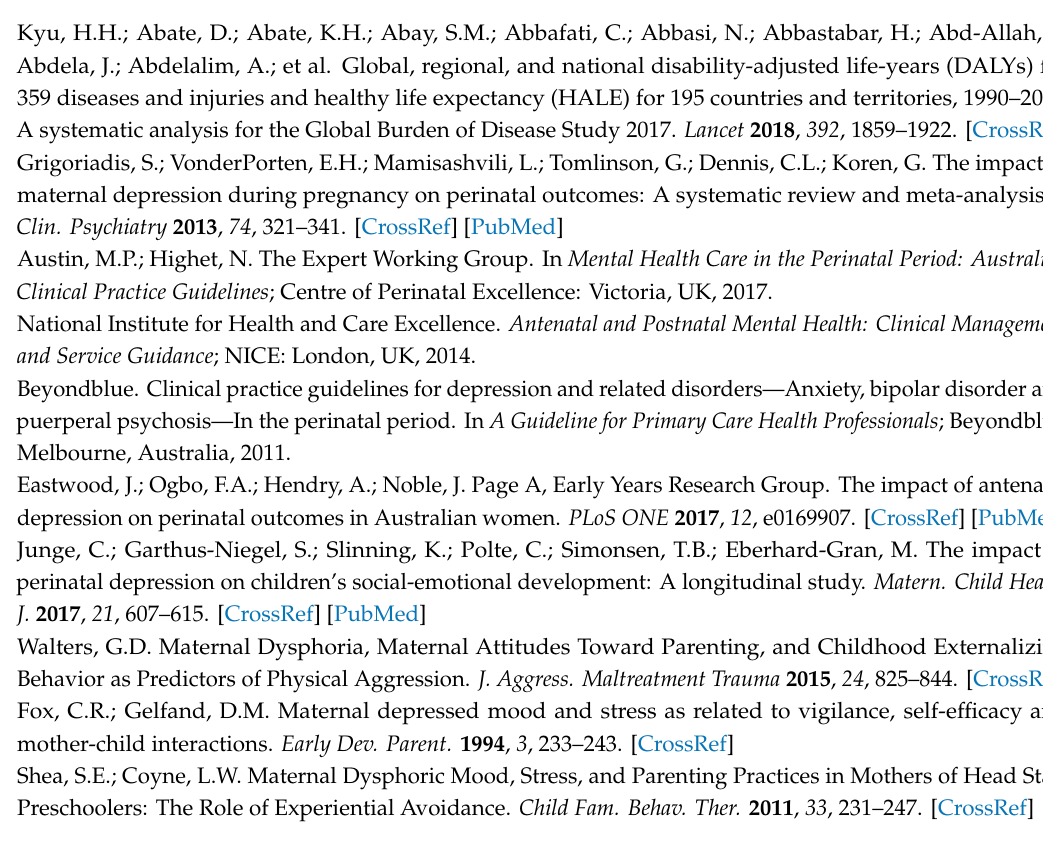
Table S1: Characteristics of the study